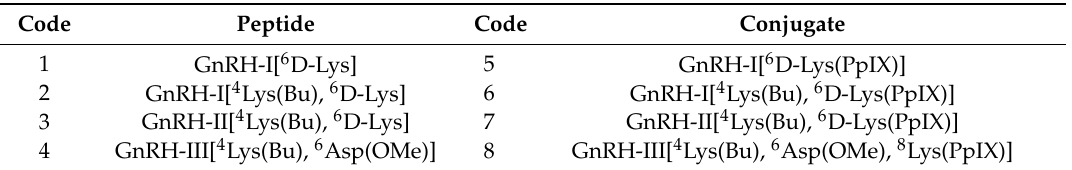
Figure 3. Synthesis of the GnRH-protoporphyrin conjugates on the example of GnRH-I[ 6 D -Lys] (compound 1 ) and PpIX reaction (resulting in compound 5 , GnRH-I[ 6 D -Lys(PpIX)]). The coupling was performed in DMF with PyBOP (benzotriazol-1-yl-oxytripyrrolidinophosphonium hexafluorophosphate) in the presence of DIPEA (diisopropylethylamine) (16 h, r.t.). Table 1. The synthesized compounds: the linkable targeting peptides (GnRH analogs; 1 – 4 ) and their PpIX conjugated derivatives ( 5 – 8